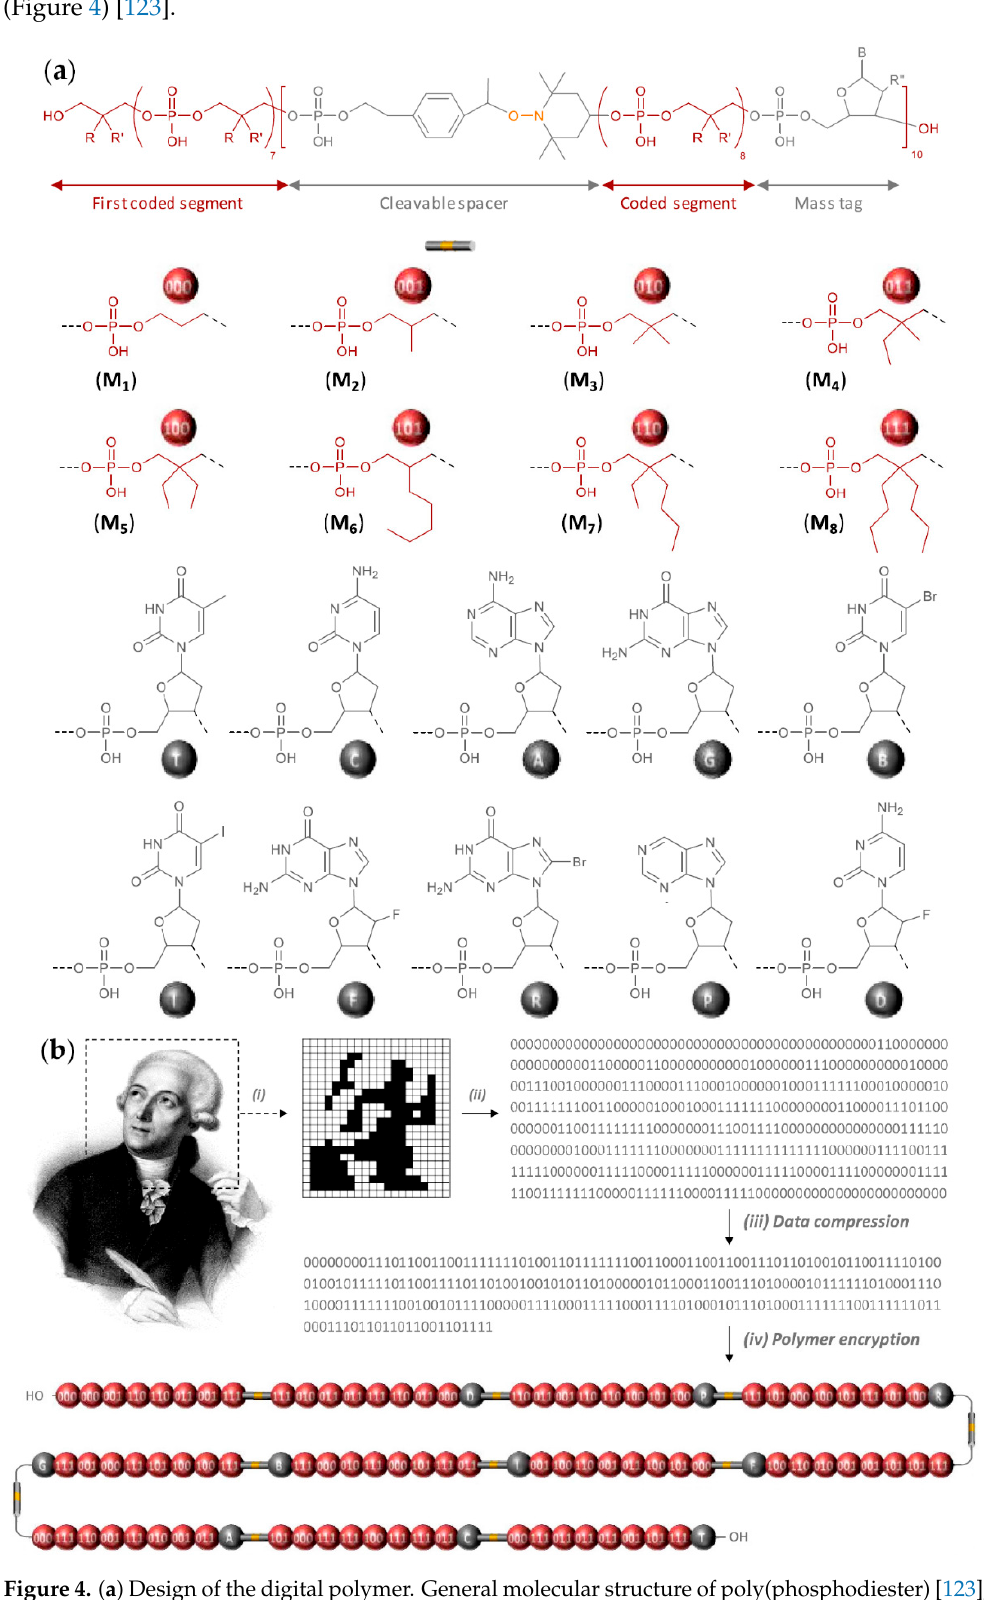
Figure 4. ( a ) Design of the digital polymer. General molecular structure of poly(phosphodiester) [123], structure of the eight synthons that permit to code binary information in the chains, and